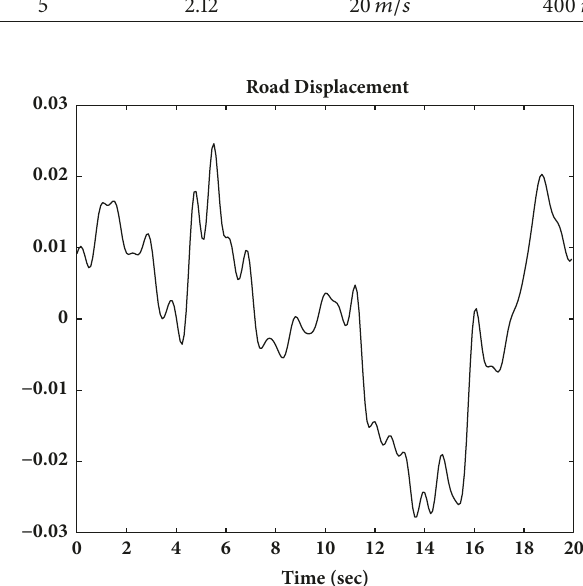
Figure 2: The curve of the road displacement 𝑧 𝑟 (𝑡) .